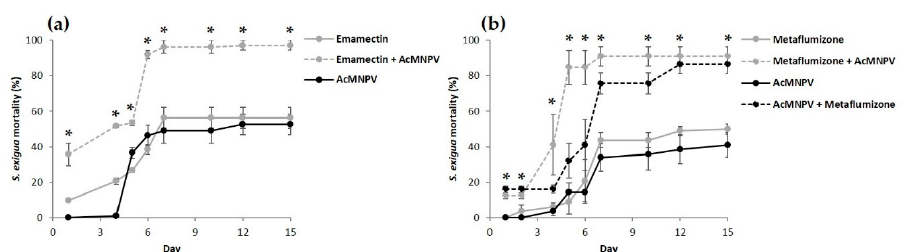
are represented by gray bars. Significant χ 2 showing synergy are in bold. Tabular χ 2 with df = 1 and p ≤ 0.05 is 3.84.